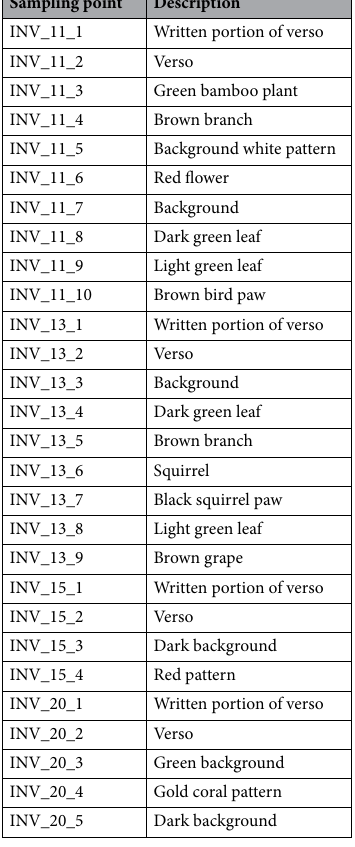
Table 1. Description of the sampling points of the four analysed